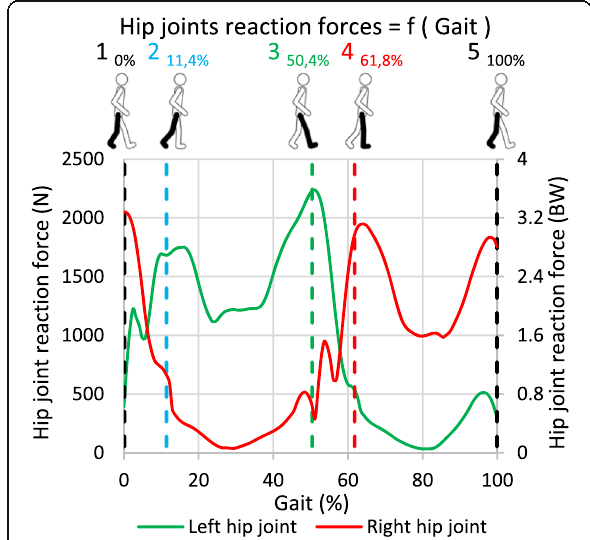
Fig. 2 Hip joint reaction forces during